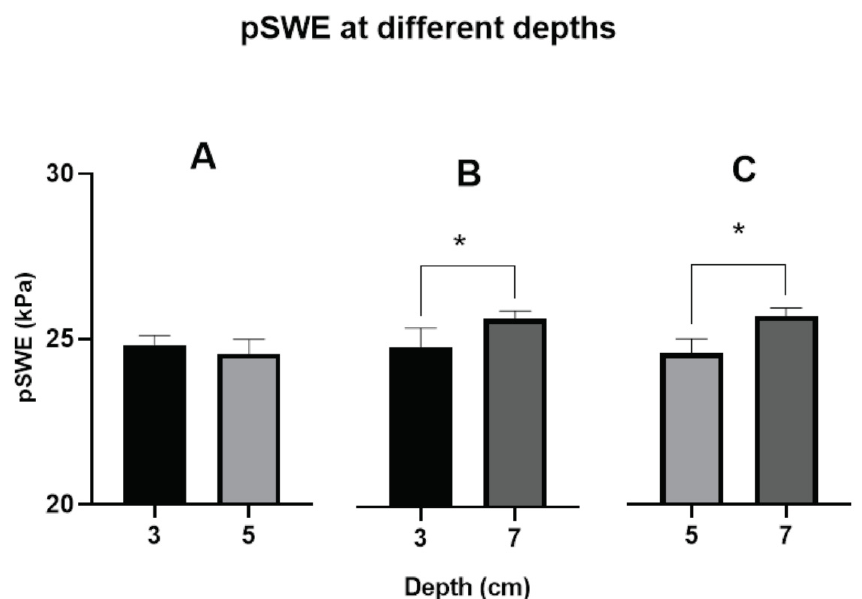
Figure 3. Comparison between pSWE measurements at different depths. Significant differences be- tween pSWE measurements at depths of three cm vs. seven cm ( p = 0.024, ( B )) and between pSWE at depths five cm vs. seven cm ( p = 0.001, ( C )) were noted. No significant differences in pSWE at depths of three cm vs. five cm ( p = 0.44, ( A )). Mean, SEM (* p < 0.05 using Independent t -test between pSWE measurements at different depths, number of pSWE measurements per depth = 60).